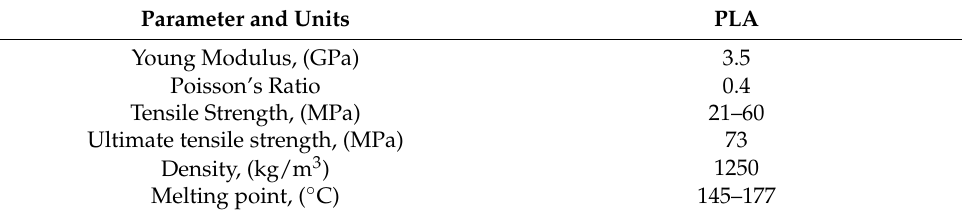
Table 4. Properties of PLA